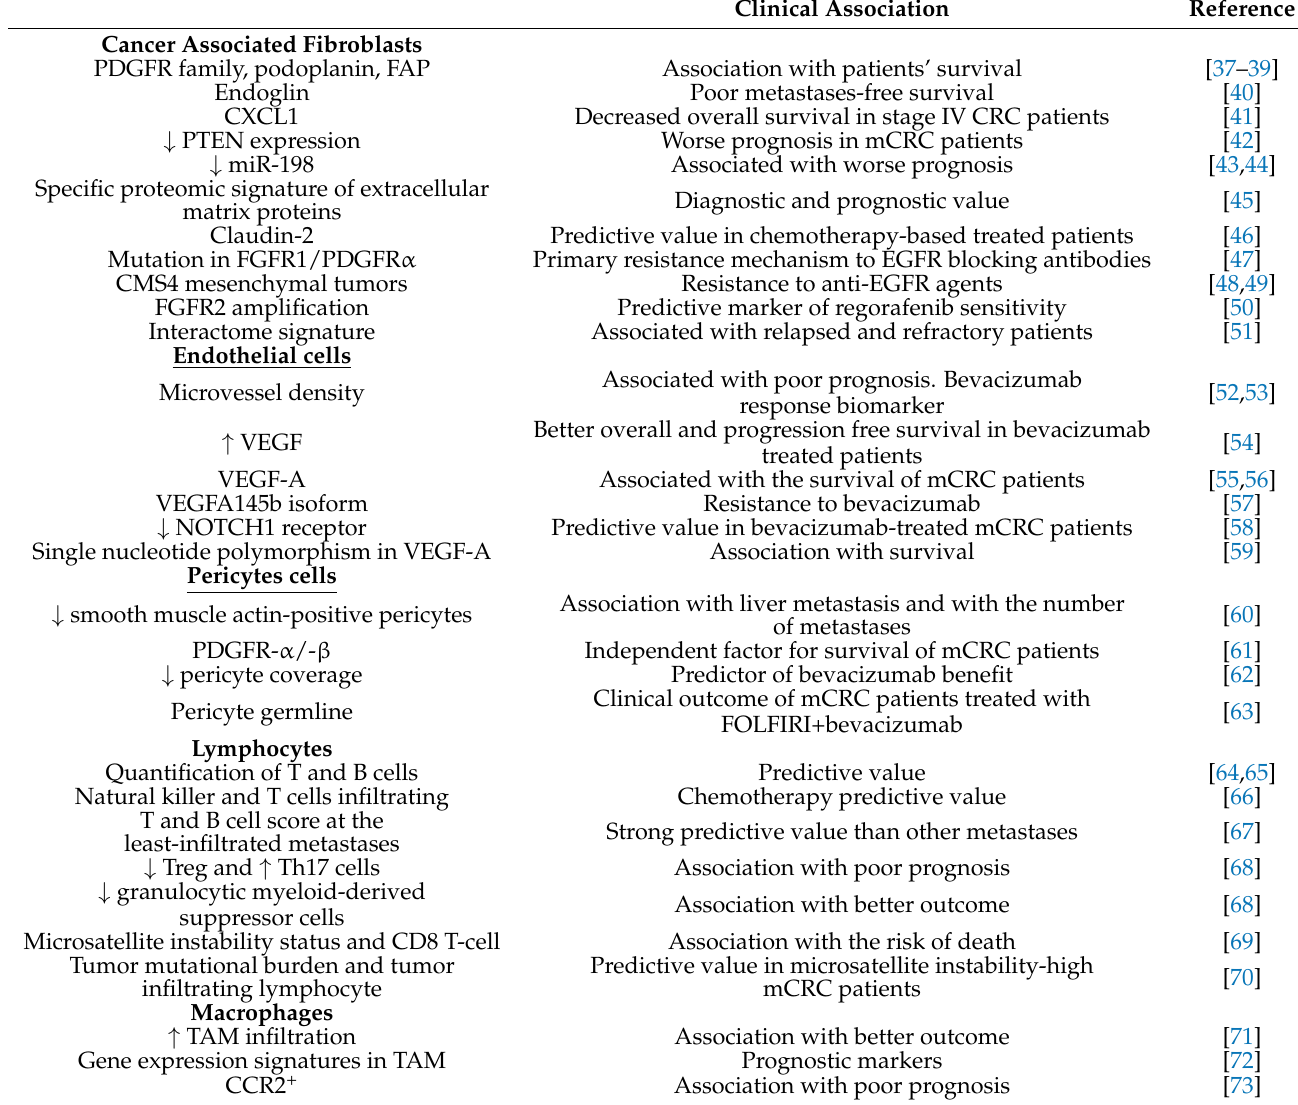
Table 2. Prognostic and predictive biomarkers in the tumor microenvironment of mCRC. Clinical